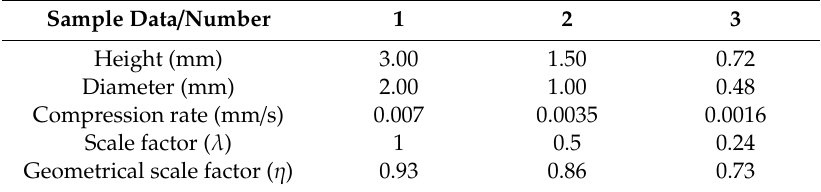
Table 1. Geometrical dimensions and process parameters for micro-upsetting.